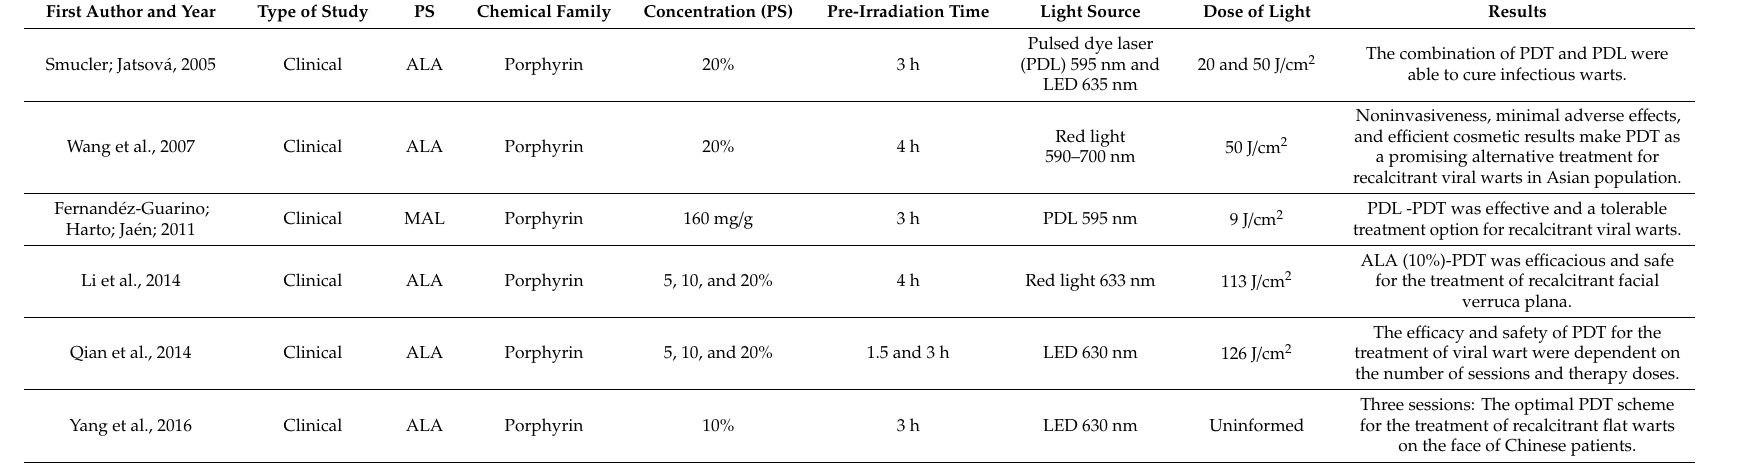
Table 4. The studies that used porphyrins in the treatment of HPV viral